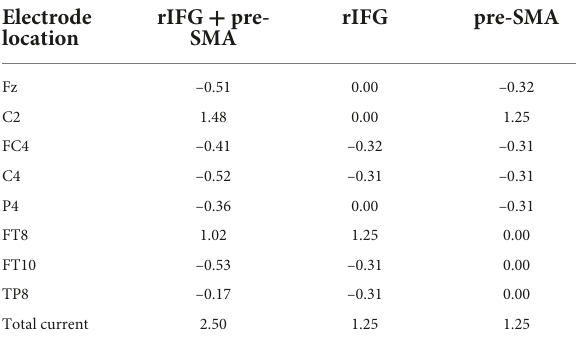
TABLE 2 Location and current intensity (mA) of each electrode for each verum stimulation condition, according to the international 10-10